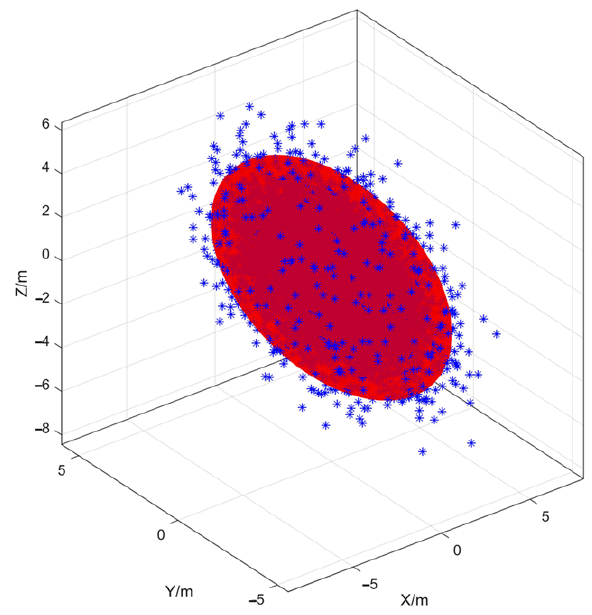
Figure 4. Three-dimensional position error ellipsoid.